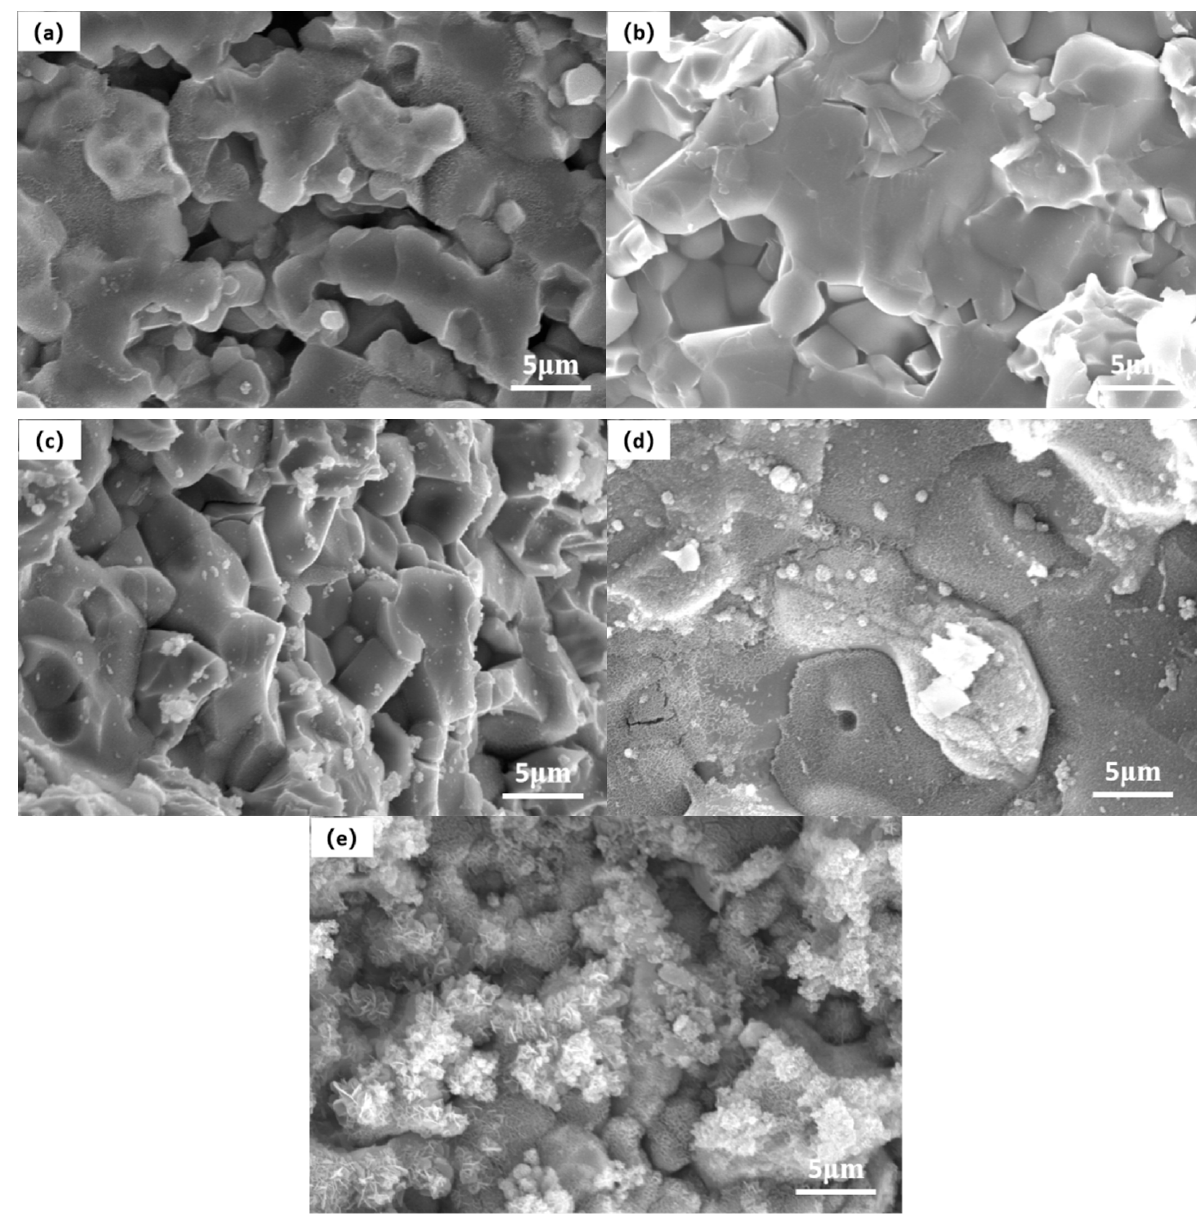
Figure 4. SEM micrographs of the fracture surface of Fe (bright area)/FeAl 2 O 4 (dark area) composites: ( a ) S1; ( b ) S2; ( c ) S3; ( d ) S4; ( e ) S5.